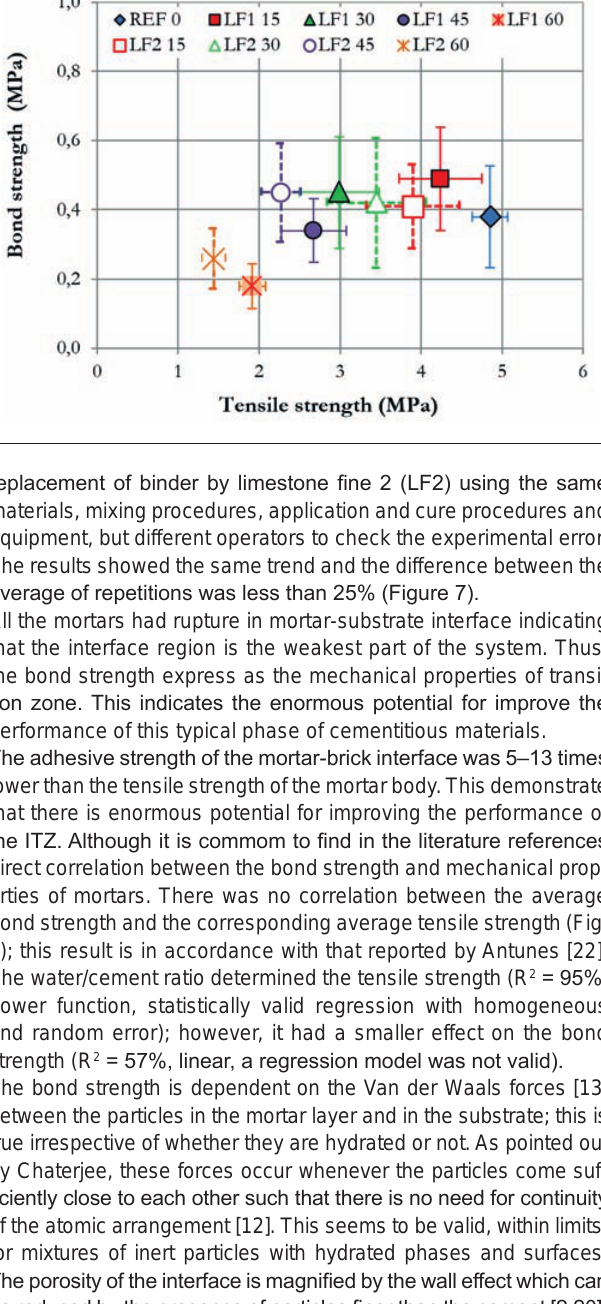
Figure 9 – Binder intensity indicator (b ) for tensile strength of mortars. iTensile strength This indicator was more ou less contant for mortars with replecement of binder for limestone up to 30% for both fines; and at higher levels there was a reduction in binder